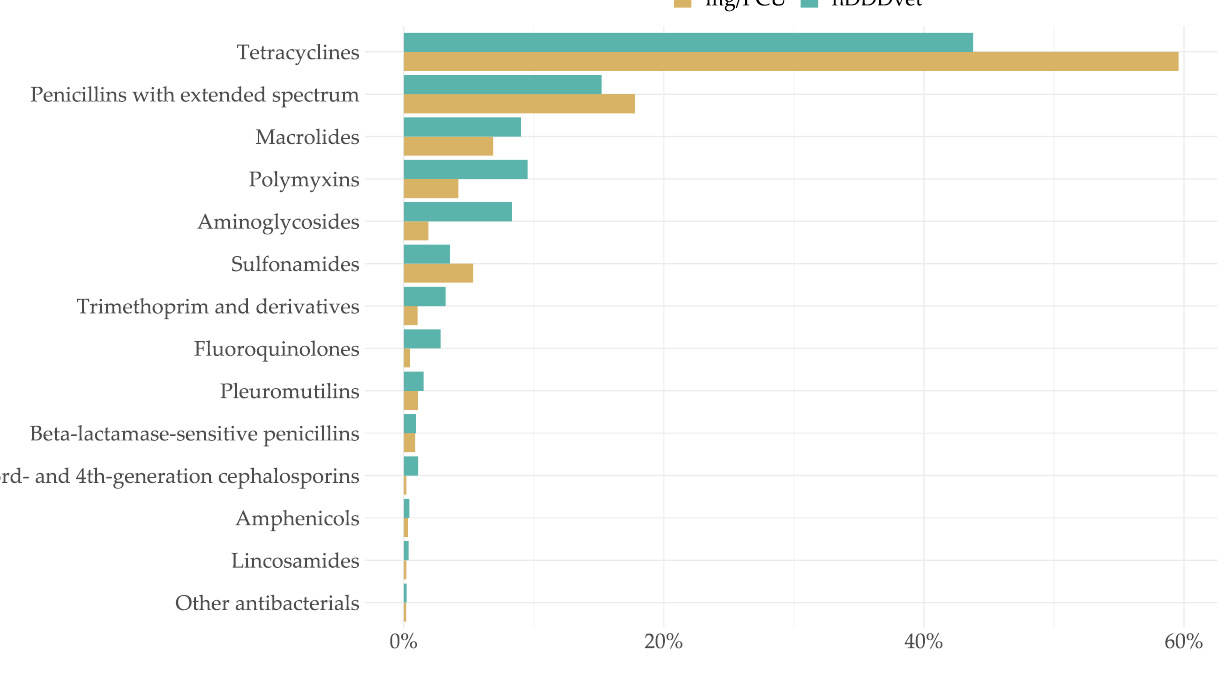
Figure 3. Comparison of the mean proportions of mass-based and dose-based metrics for antimicro- bial classes dispensed for use in pigs in Austria in